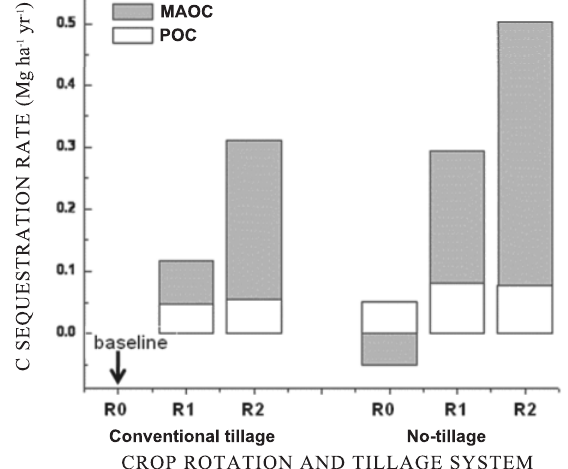
Figure 4. Annual carbon sequestration rates in the 0–0.30 m layer of a subtropical Oxisol under two tillage systems (conventional tillage-CT and no tillage-NT) under three crop rotations (R0=wheat/soybean; R1=wheat/soybean/ black oat/soybean; R2=black oat/soybean/black oat+common vetch/maize/oilseed radish/wheat/ soybean) taking (baseline) the traditional soil management system adopted by farmers (CT R0) as control. POC = particulate organic carbon; MAOC= mineral-associated organic